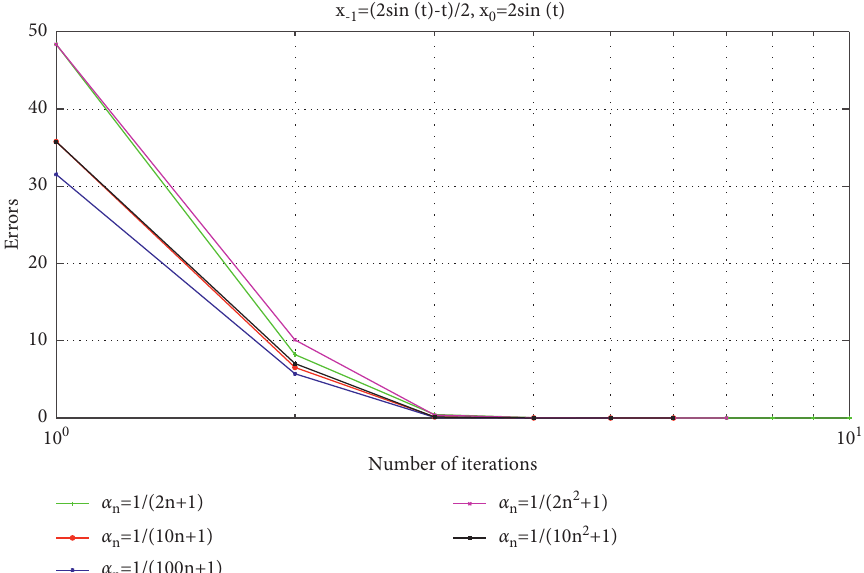
Figure 8: The Cauchy error plotting number of iterations for different parameters α